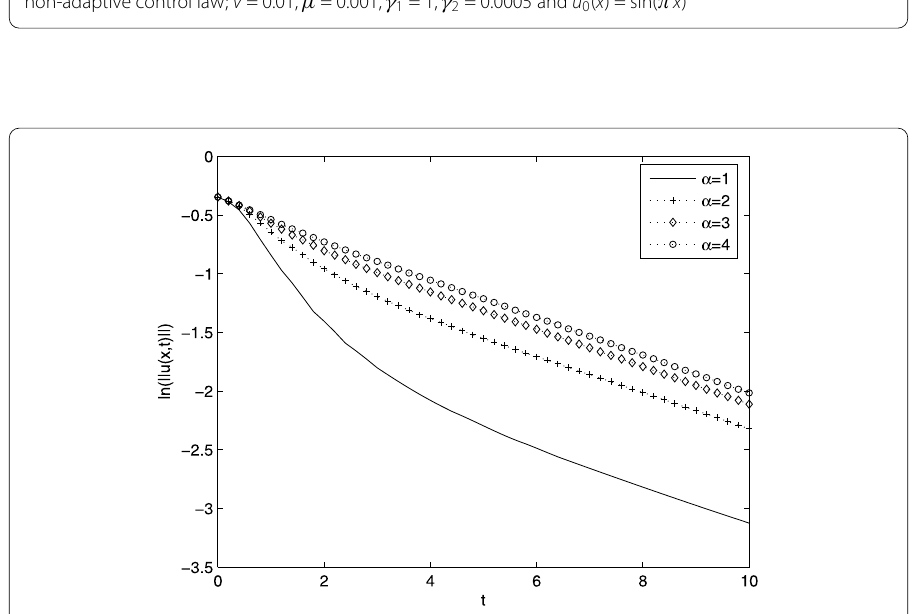
Figure 9 The natural logarithm of the L 2 -norm of u ( x , t ), ln( (cid:7) u ( x , t ) (cid:7) ), versus time for various values of α when using the second nonlinear non-adaptive control law; v = 0.01, μ = 0.001, γ 1 = 1, γ 2 = 0.0005 and u 0 ( x ) = sin( π x )